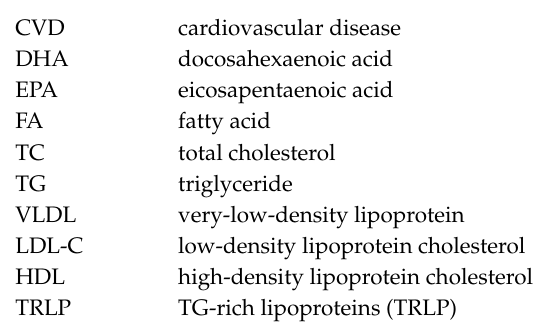
Table S1: The list of inclusion and exclusion criteria; Figure S1: Protein-protein interactome map and top 10 enriched GO terms of HDL-related APOM (A), AFM (B), and GSN (C) significantly altered by EPA-rich fish oil compared with DHA-rich fish oil supplementation based on STRING database (http: // string-db.org / ) with moderate confidence (0.40). The HDL fractions were isolated by fast protein liquid chromatography (FPLC) from a subgroup of random 10 subjects. GO: gene ontology; FDR: false discovery